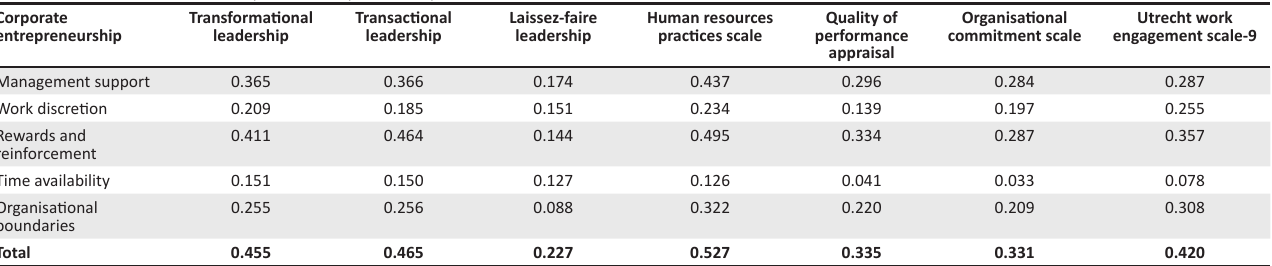
TABLE 6: Correlation between Corporate Entrepreneurship Assessment Instrument scores and related